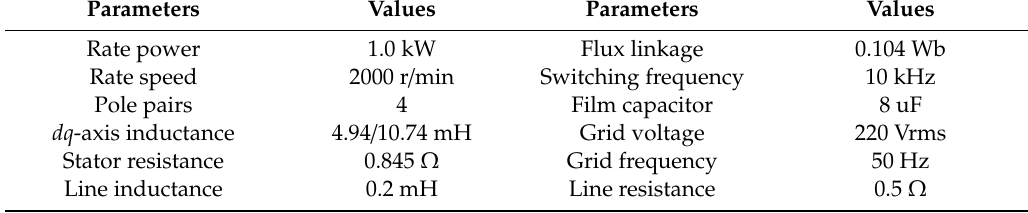
Table 1. Drive and system parameters.